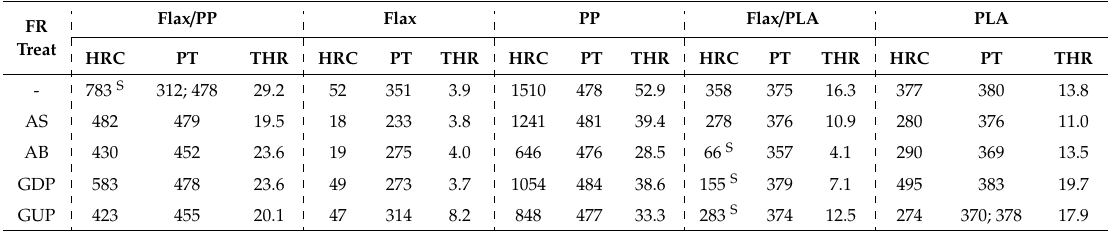
Table 2. PCFC results of unmodified and fire retarded Flax, PP, PLA, Flax / PP, and Flax / PLA